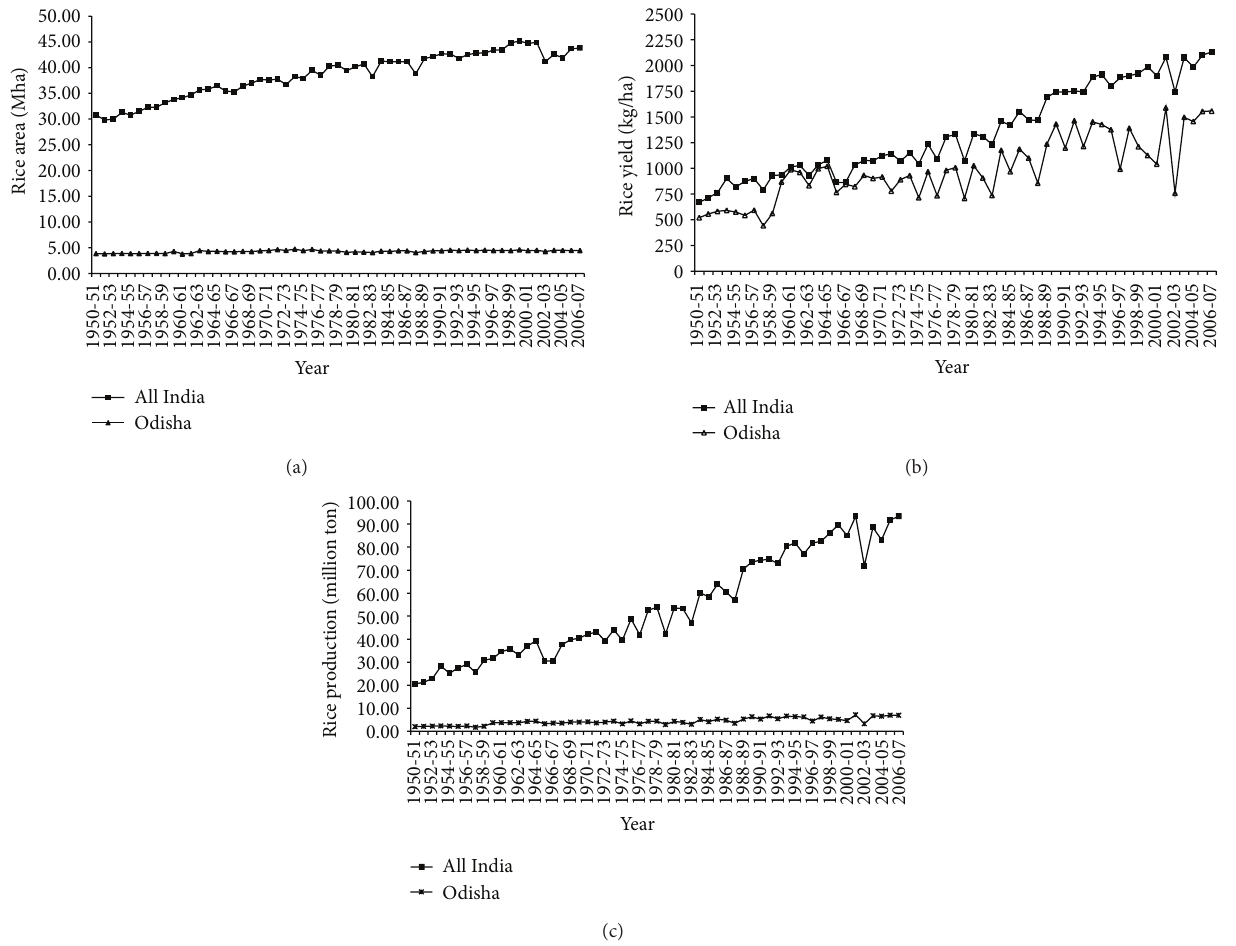
Figure 1: Trend of area, productivity, and production of rice in Odisha and India. (a) Area, million hectare; (b) productivity, kg ha −1 , and (c) production, million